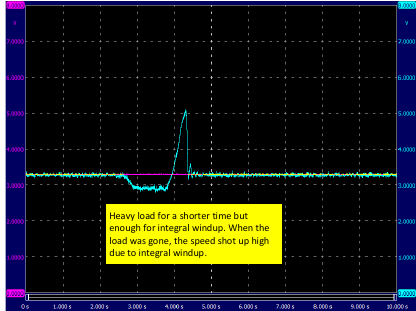
Fig. 8. Tachometer signal showing the effect of integrator windup